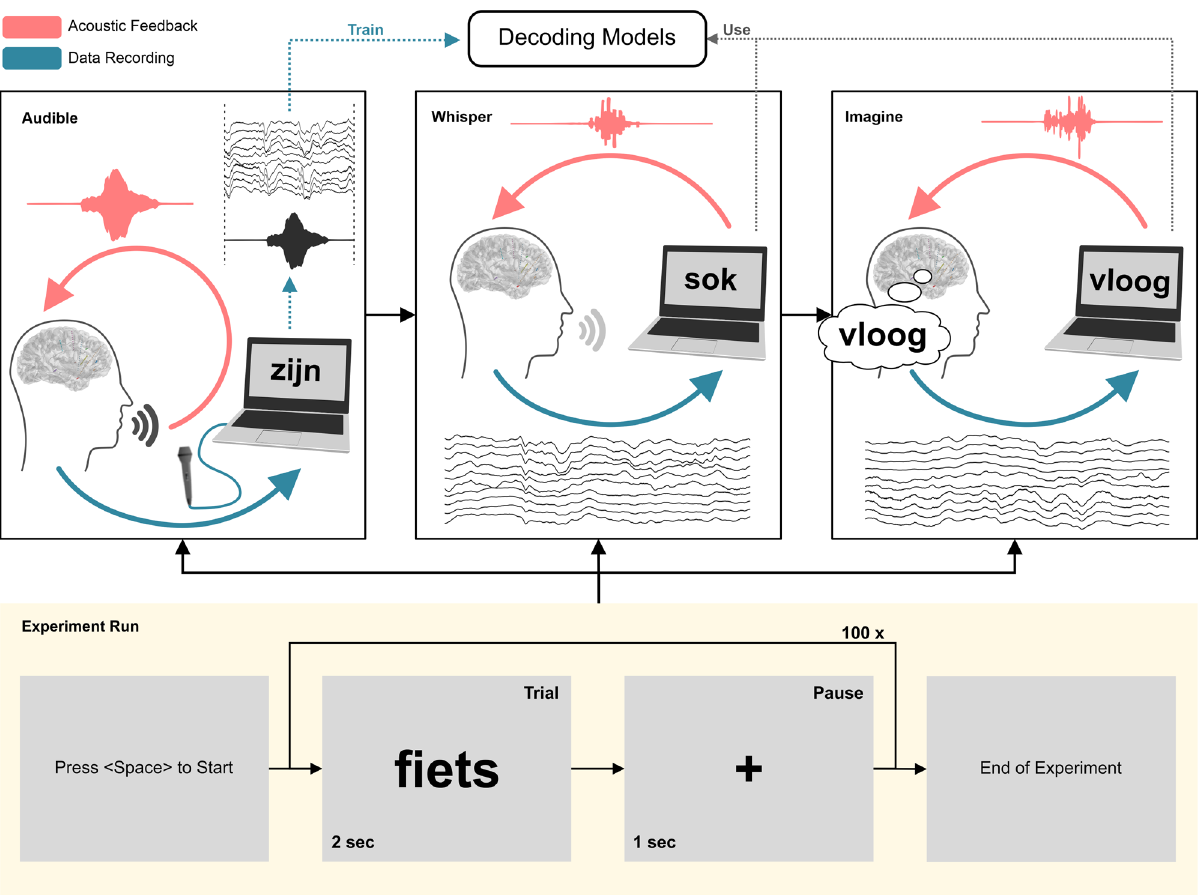
Fig. 1 Overview of experimental design. The experiment begins with an open-loop run in which the participant reads a series of 100 words aloud while the speech and brain activity are synchronously recorded. In the two subsequent closed-loop runs, the participant performs the same task while whispering and imagining speech, respectively. For the closed-loop runs, real-time audible feedback of the neurally-decoded and synthesized speech is provided via our system.